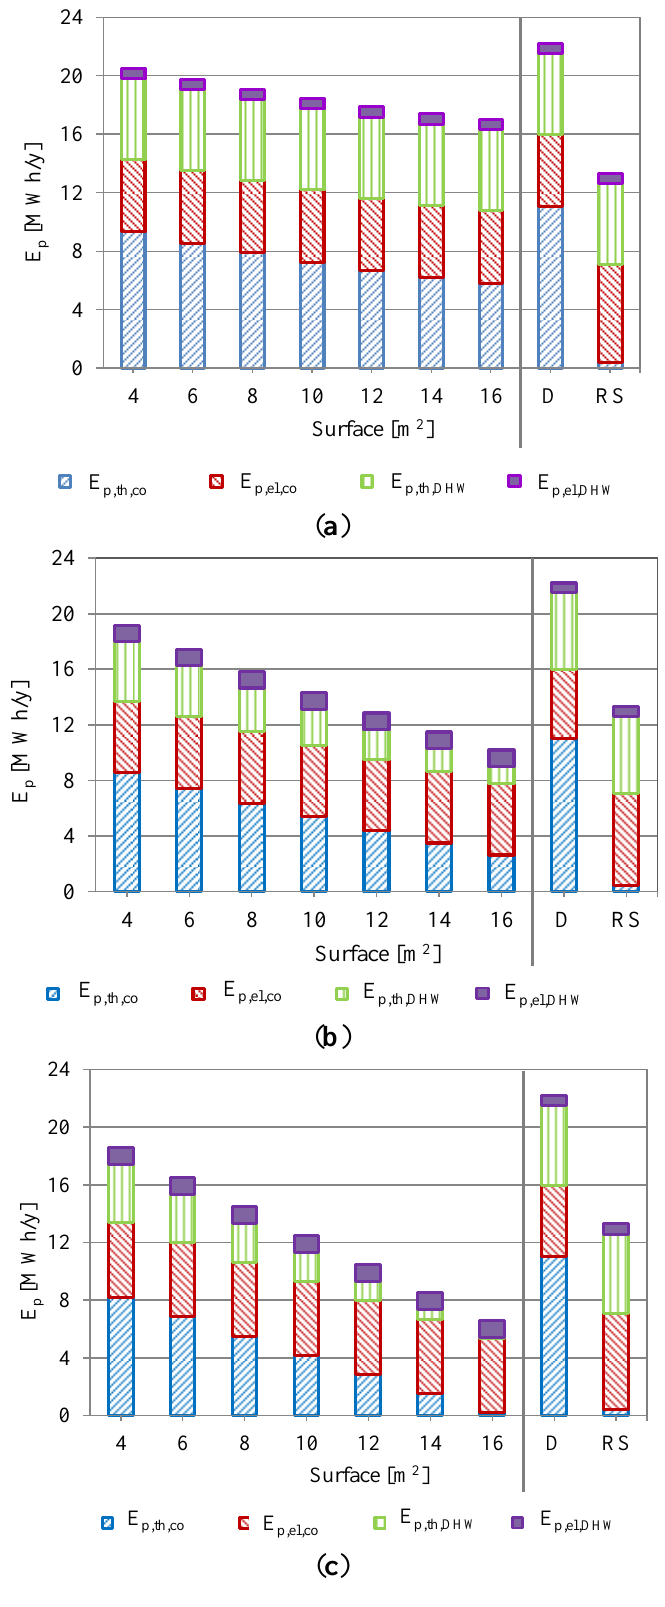
Figure 7. Primary energy demands associated with electric and thermal